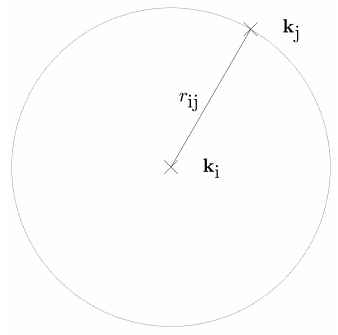
Figure 5. Knowing the distance between the pivotal anchor and the encompass anchor, the pivotal anchor must lie in a circle whose center is the encompass anchor.